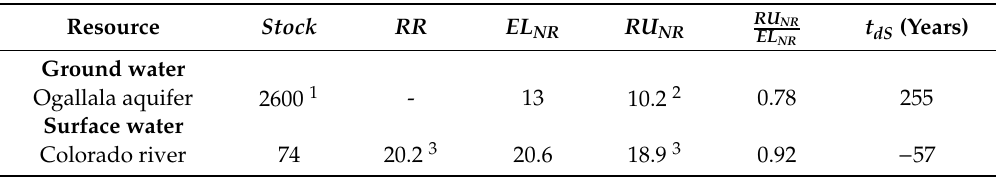
Table3. Environmentalsustainabilityassessmentoffreshwaterresources[ t S = 200years](units: stock –Gt; RR , EL NR , RU NR –Gt year − 1